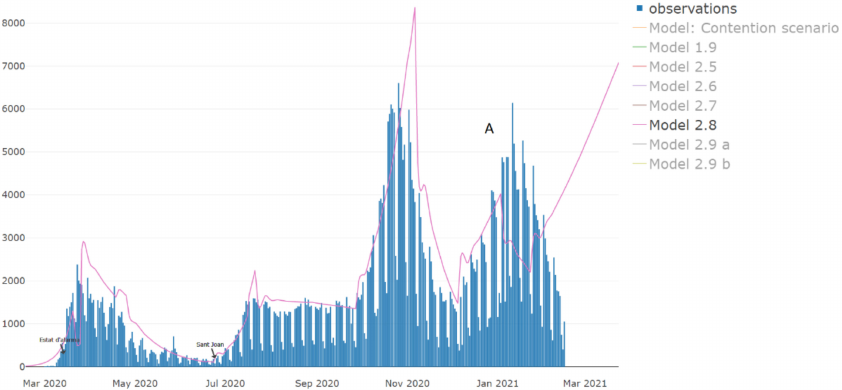
Figure 7. Model 2.8 with the forecast for the second wave for the new cases ( y -axis). Notice the divergence between the trend of the model and point A, the highest value of the data. We are presenting a scenario considering that the Christmas holidays have no acute effects on the β .